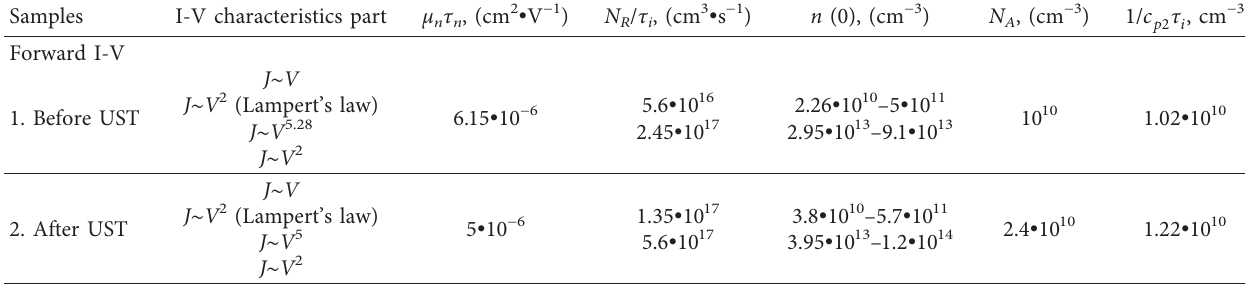
Table 1: Parameters determined from the I-V